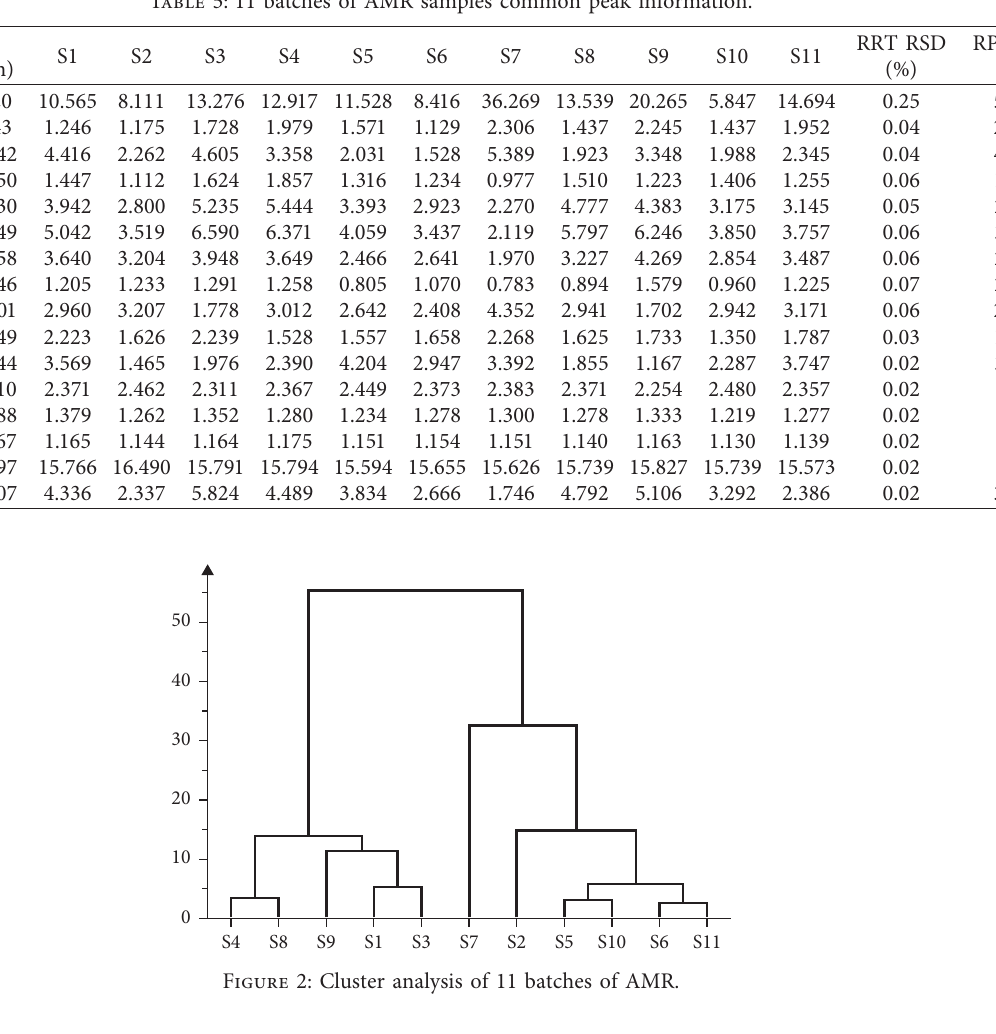
Table 5: 11 batches of AMR samples common peak information.